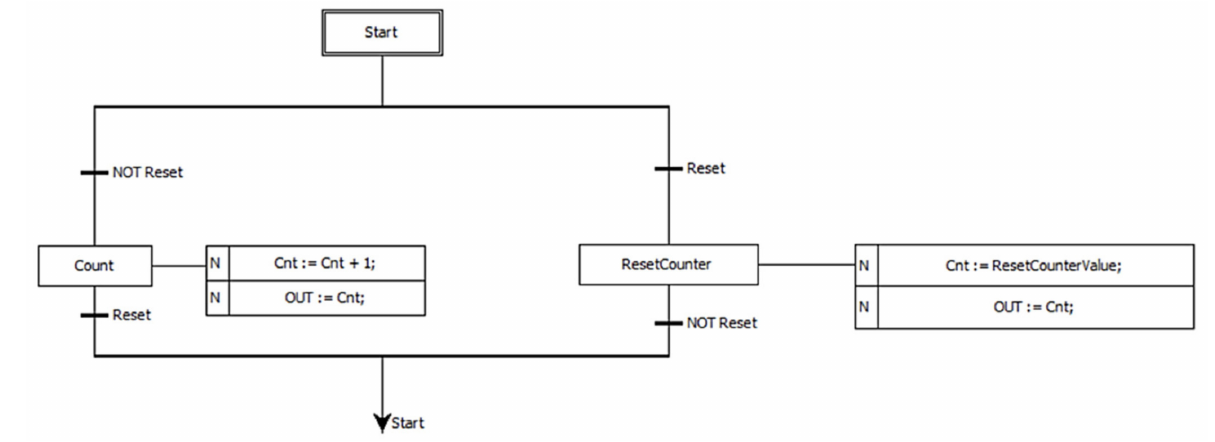
Figure 11. Sample PLC program implemented with SFC graphic language in Bremiz environment.